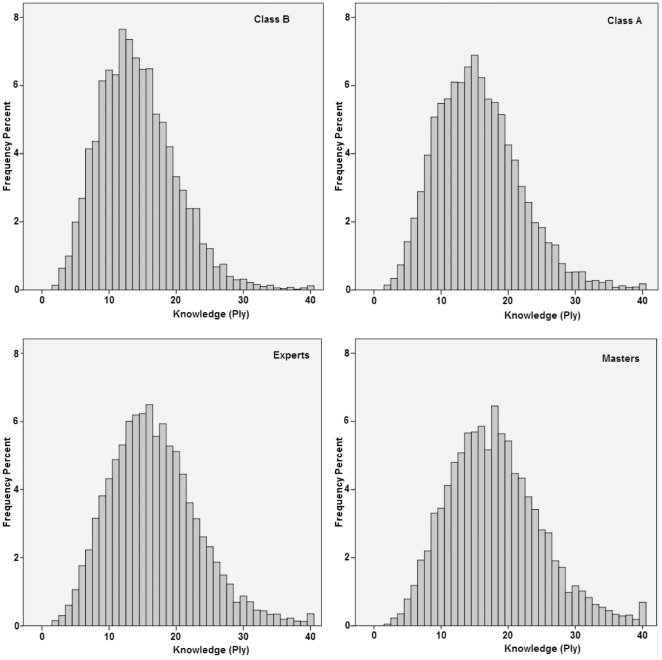
Frequency distribution of opening knowledge, for each skill level.With Fritz, all novelties at ply 40 and above (0.41% of the sample) are scored at ply 40 and are not shown in the histograms.